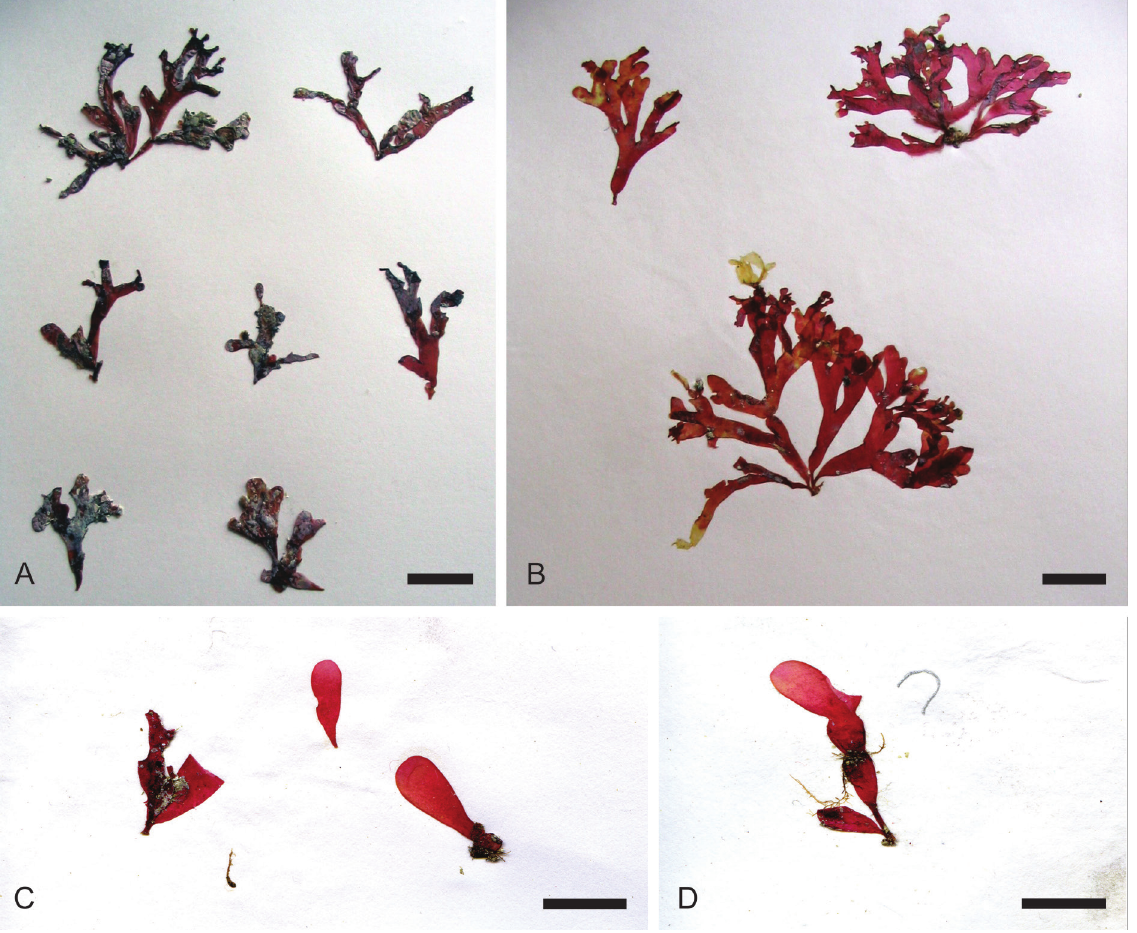
Fig. 1. A – B . Herbarium sheets MS35027-1 and MS35027-14, respectively, both from Sicily. C – D . Herbarium sheets PC0152091 (LLG0393) and PC0152089 (LLG0394), respectively, both from Vis Island, Croatia. Scale bars: A–B = 2 cm; C–D = 1